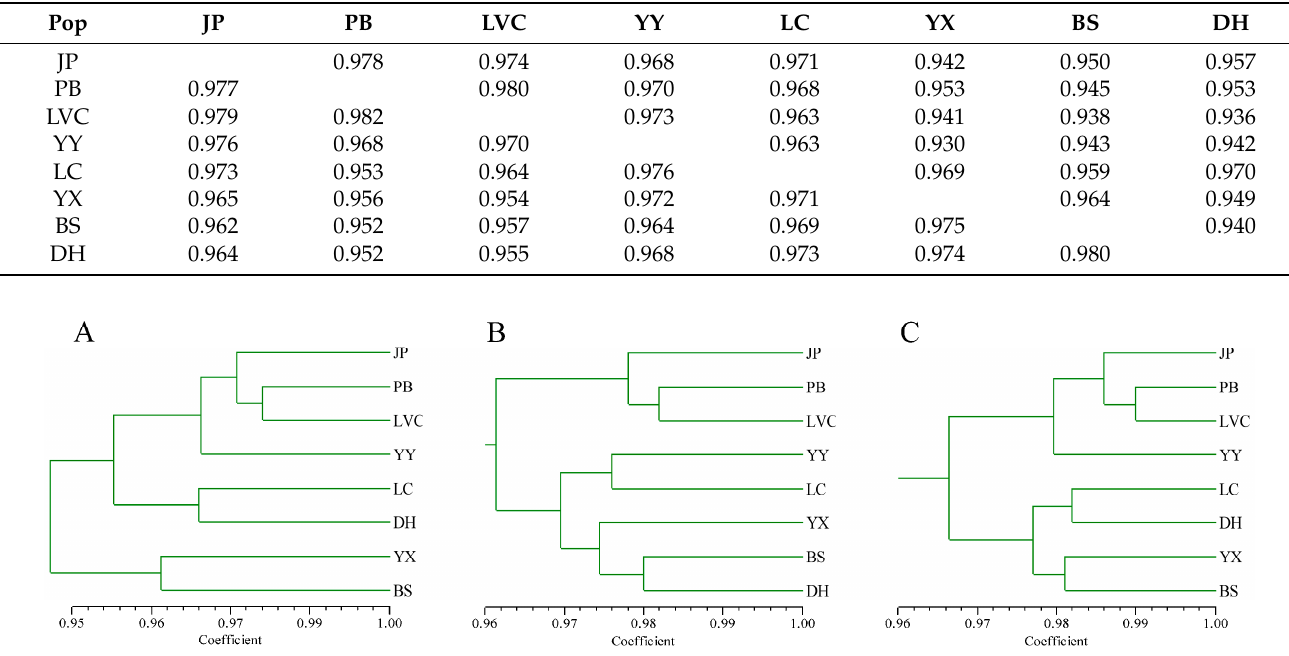
Figure 5. Unweighted pair-group method with arithmetic mean (UPGMA) dendrogram based on PAAP ( A ), CDDP ( B ), and PAAP + CDDP ( C ) markers for the eight A. tsao-ko populations.